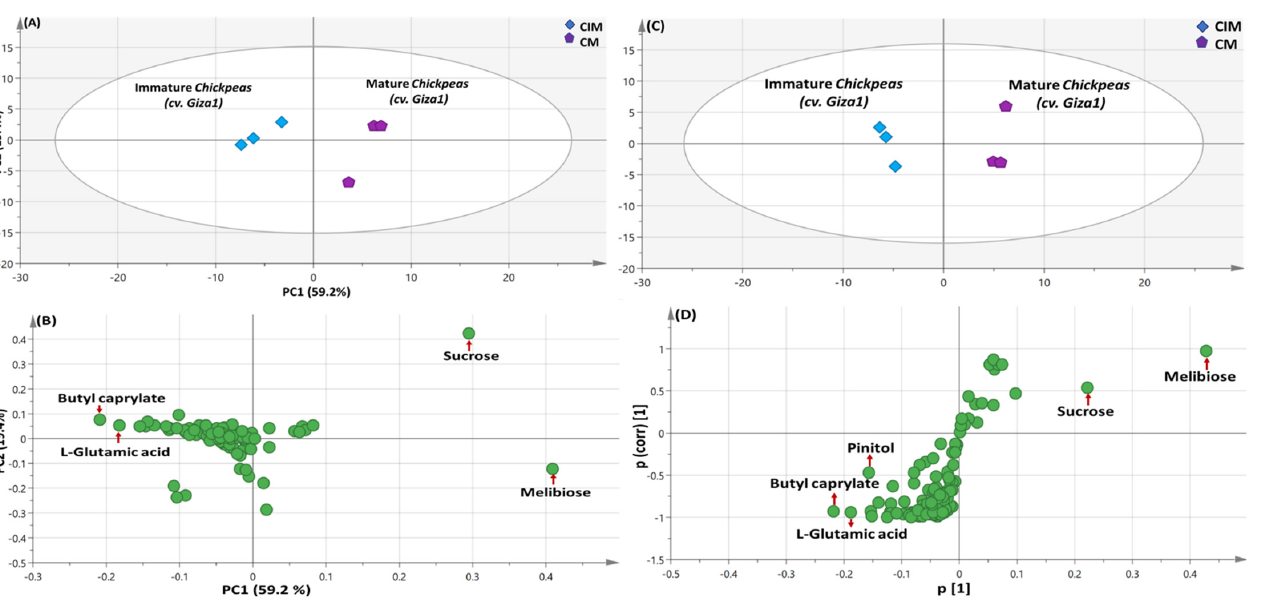
Figure 5. GC/MS-based PCA and OPLS analysis of metabolites analyzed in mature vs. immature C. arietinum (sp. Giza 1). ( A ) PCA score plot of PC1 against PC2. ( B ) Loading plot for PC1 and PC2, with contributing primary metabolites and their assignments. The metabolome clusters are located at the distinct positions in two-dimensional space described by two vectors of principal component 1 (PC1) = 59.2% and PC2 = 19.4%. ( C ) OPLS-DA score plot derived from modeling silylated primary metabolites of mature vs. immature Cicer arietinum (cv. Giza 1 ) specimens ( n = 3). The respective load- ing S-plots ( D ) show the covariance p[1] against the correlation p(cor)[1] of the variables of the dis- criminating component of the OPLS-DA model. Cut-off values of p = 0.06 were used. Designated variables are highlighted and identifications are discussed in the text.